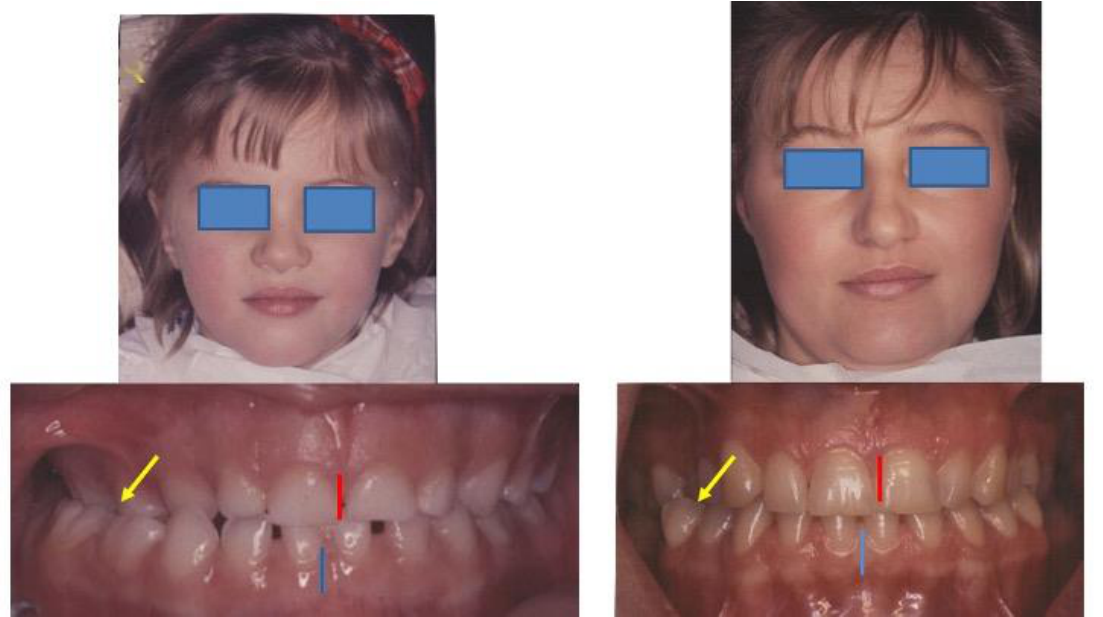
Figure 4. Dental malocclusion with lateral mandibular deviation and right cross-bite. A child with rAOM and her mother with a previous history of rAOM and current periodic dizziness. The right ear was affected in both cases.